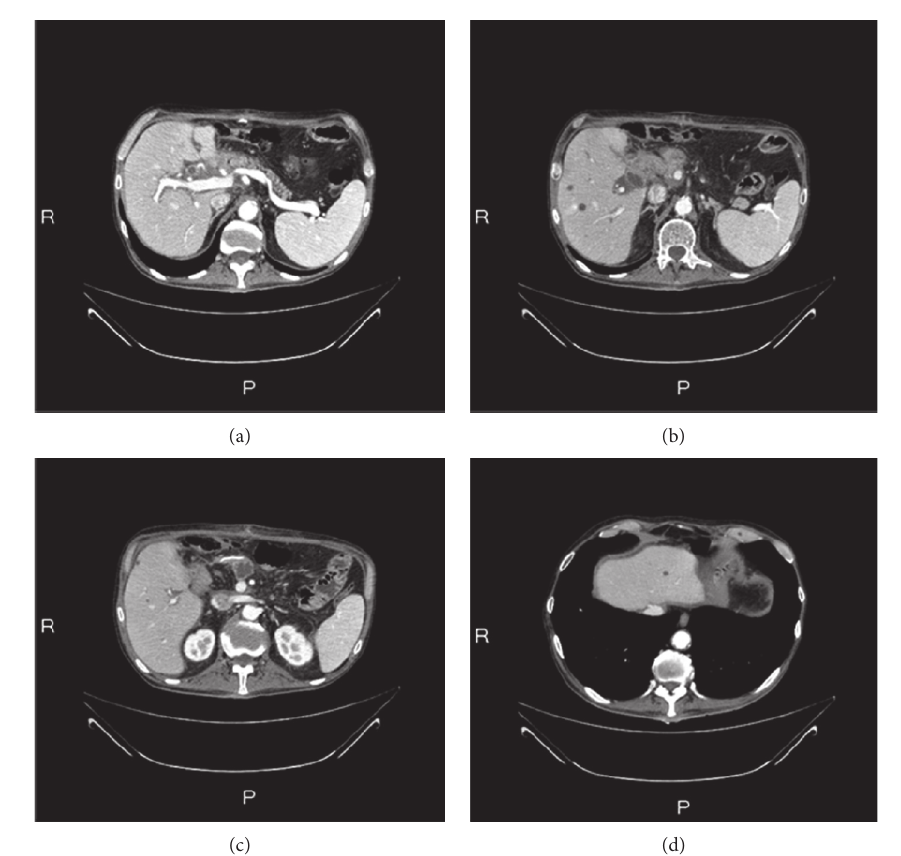
Figure 3: Radiological evaluation before surgery: primary pancreatic lesion (a) and liver metastasis